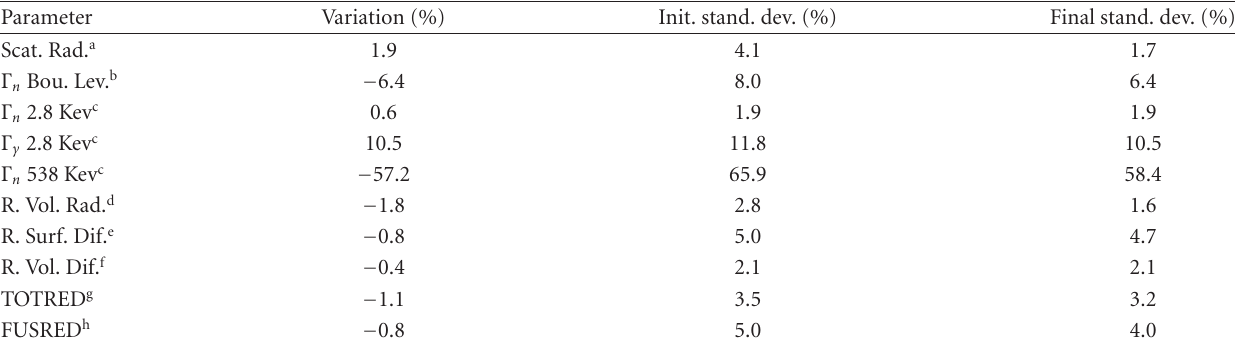
Table 7: Parameter variations and standard deviations obtained by data assimilation.